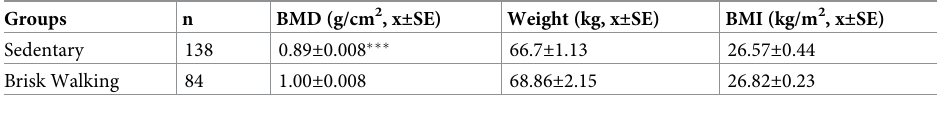
Table 1. Comparison of BMD between sedentary group and brisk walking group.